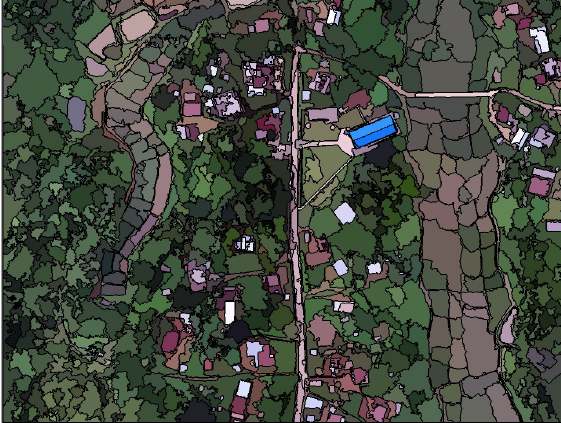
Figure 4. Part of Nongkhrah village with different land use Figure 5. Segmented image of part of the Nongkhrah